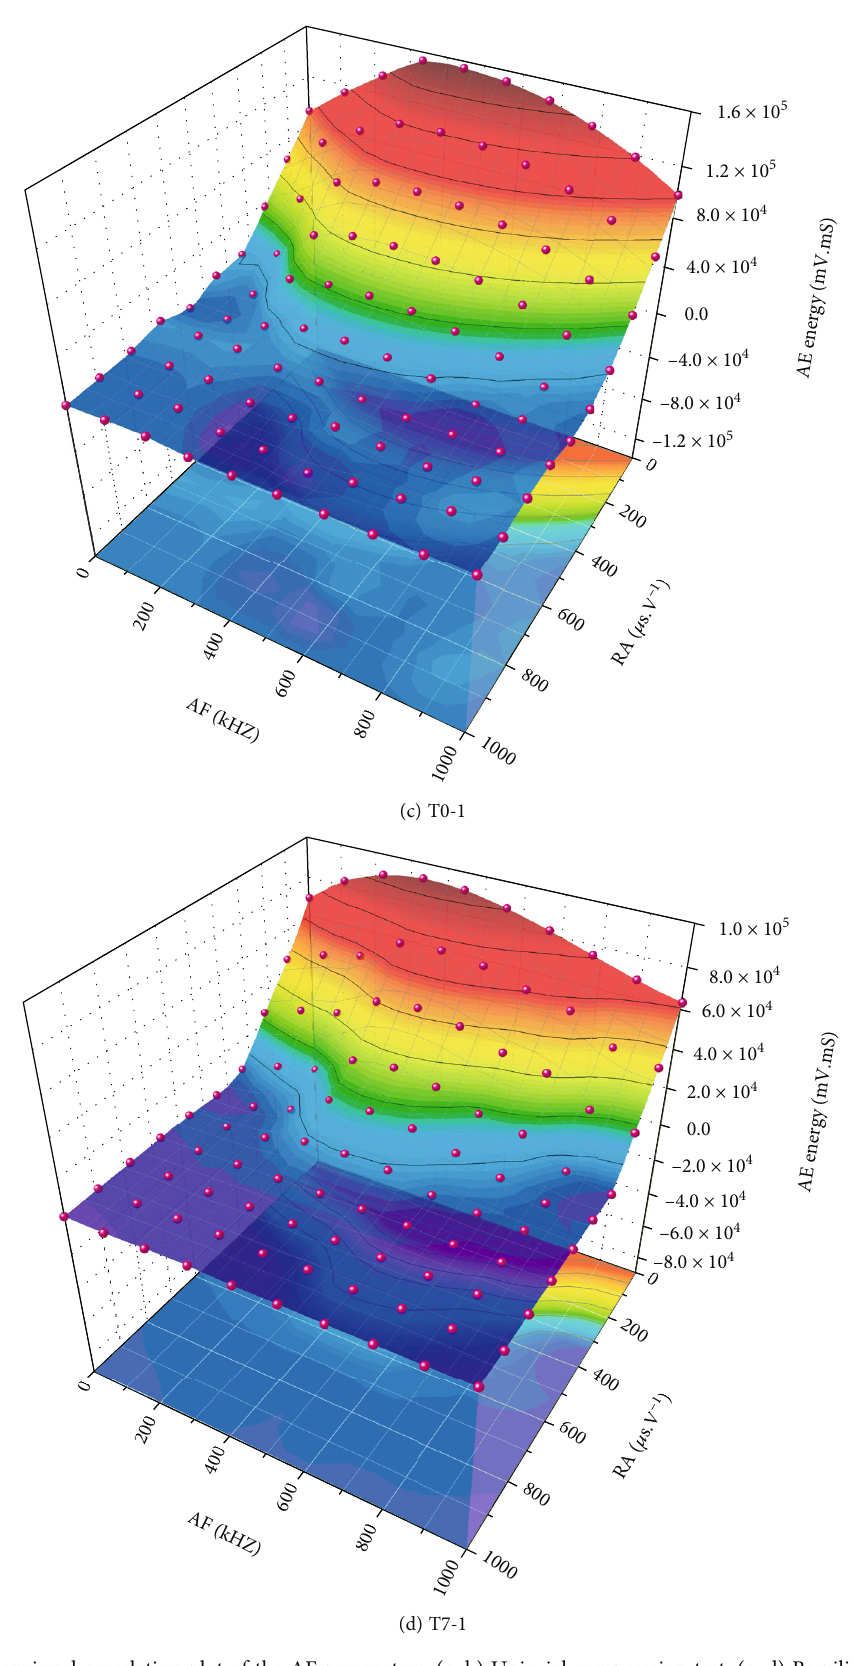
Figure 9: Three-dimensional correlation plot of the AE parameters. (a, b) Uniaxial compression test. (c, d) Brazilian indirect tensile